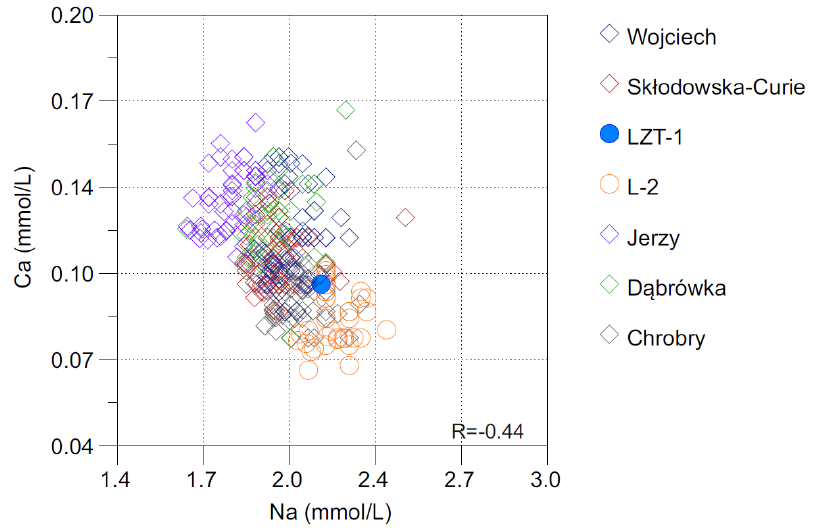
Figure 7. The relationship between the Na + and Ca 2+ ion content in waters from particular intakes (based on [44,84] updated).